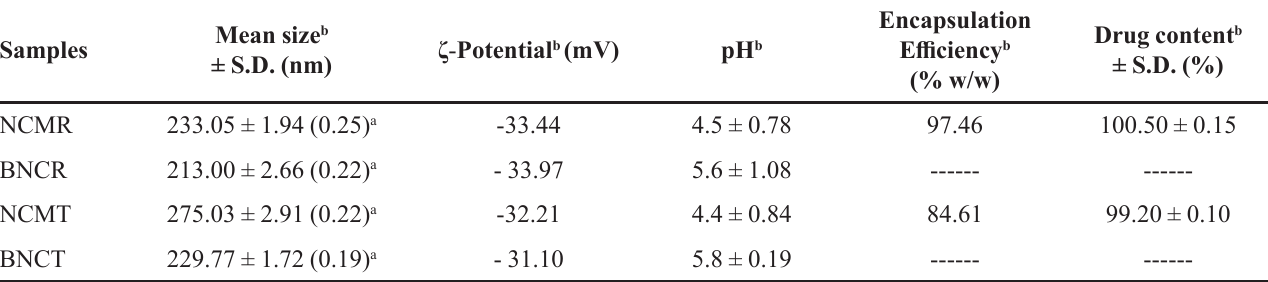
TABLE VI - Physical-chemical characteristics of nanocapsules of MUP and rosemary oil (NCMR), nanocapsules of MUP